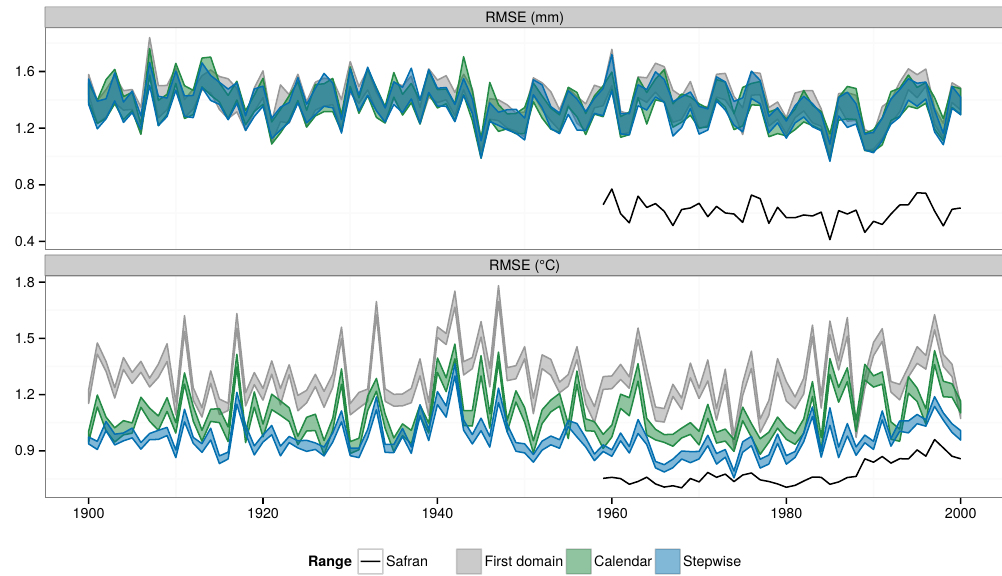
Figure 13. Temporal evolution of the precipitation and temperature RMSE for both Safran and the reconstructions with all three subselection methods, with the homogenized series as a reference. Values are initially computed at the monthly timescale. See text for